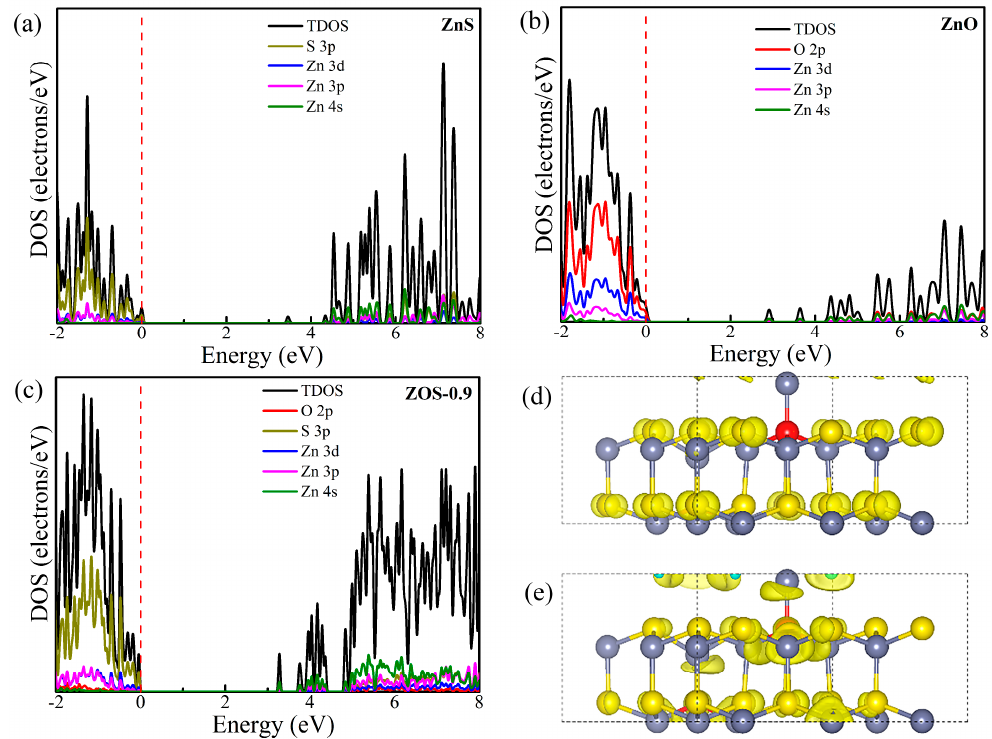
Figure 8. Partial density of states (PDOS) near Fermi level for ZnS ( a ), ZnO ( b ) and ZnO/ZnS photocatalyst ( c ), Spatial structure of wave functions of VBM ( d ) and CBM ( e ) for ZnS/ZnO photocatalyst.